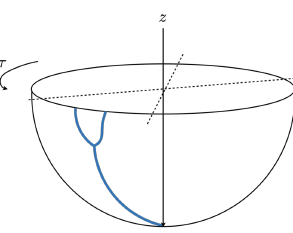
Figure 2 . A sketch of the effective configuration to consider: in Euclidean signature, we have a junction of 3 geodesic arcs. Two of them are attached to the boundary (we only show the euclidean time circle) at the insertion points of the operators and meet at a point with a third vertical geodesic anchored at the tip of the cigar (here marked as the locus to which the arrow in the z axis points). In Lorentzian signature that would be the horizon and the vertical geodesic would continue all the way to the